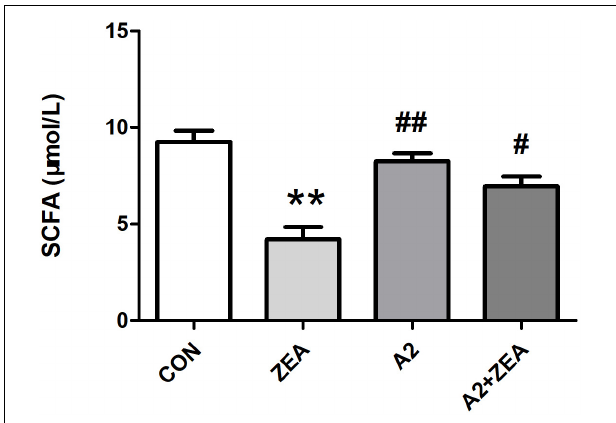
FIGURE 6 | SCFA detection of mice feces in each group. "**" means an extremely significant difference compared with the CON group ( P < 0.01). "#" means a significant difference compared with ZEA ( P < 0.05), "##" means an extremely significant difference compared with ZEA ( P < 0.01).